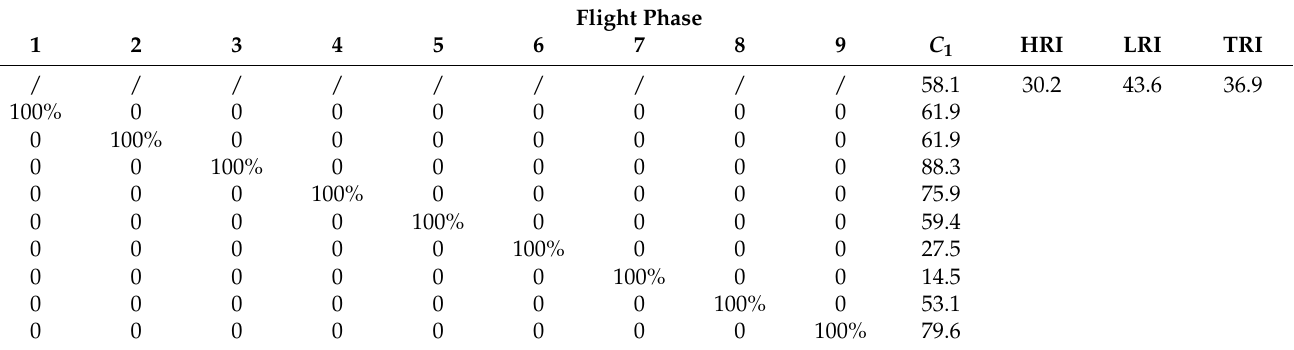
Table 4. TRI of RIF—flight phase for casualty type C 1 .